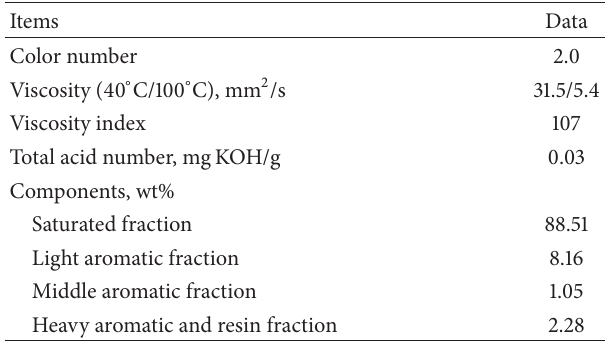
Table 7: Characters and components of ideal oil.